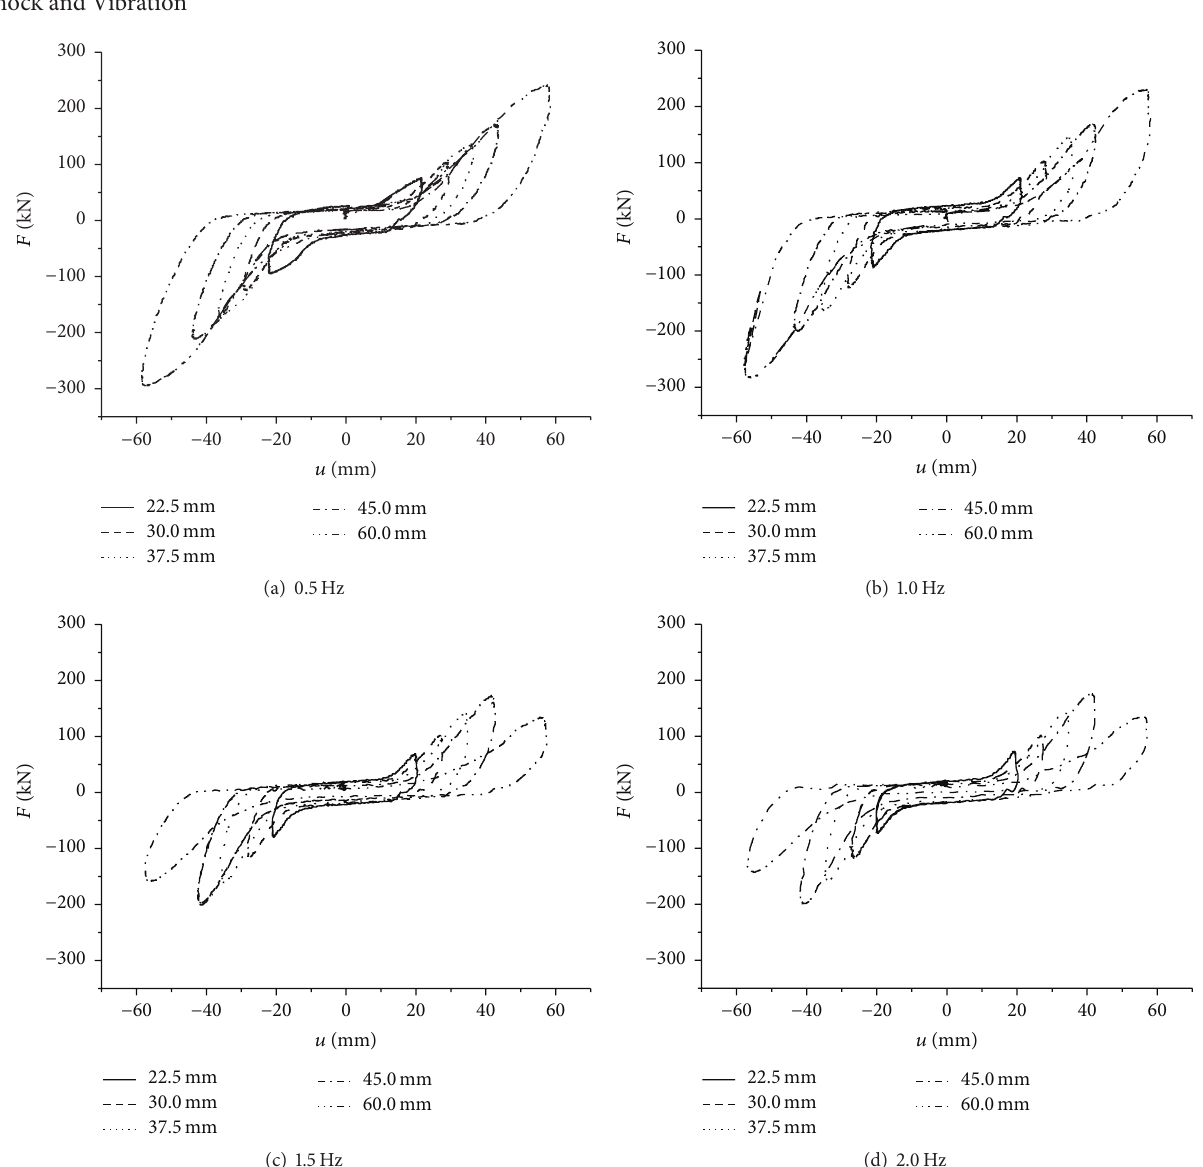
Figure 4: 𝐹 - 𝑢 hysteresis curves of VDW at different frequencies and